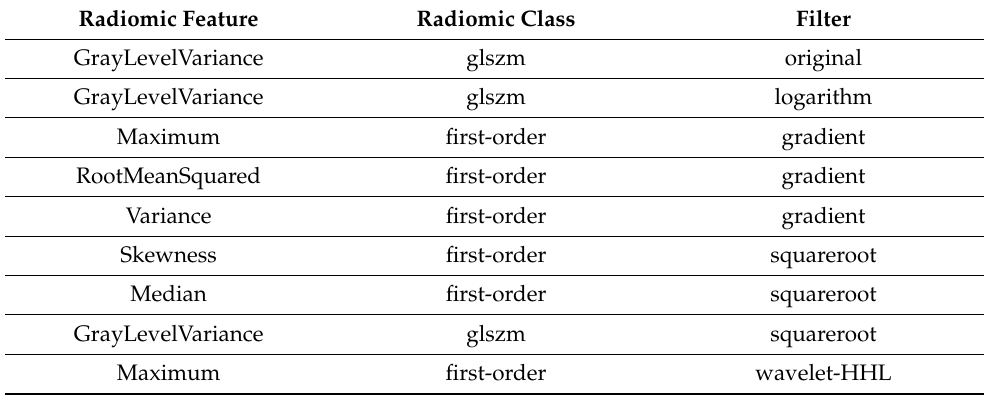
Table 1. A description of the selected radiomic features with their associated feature group and filters.